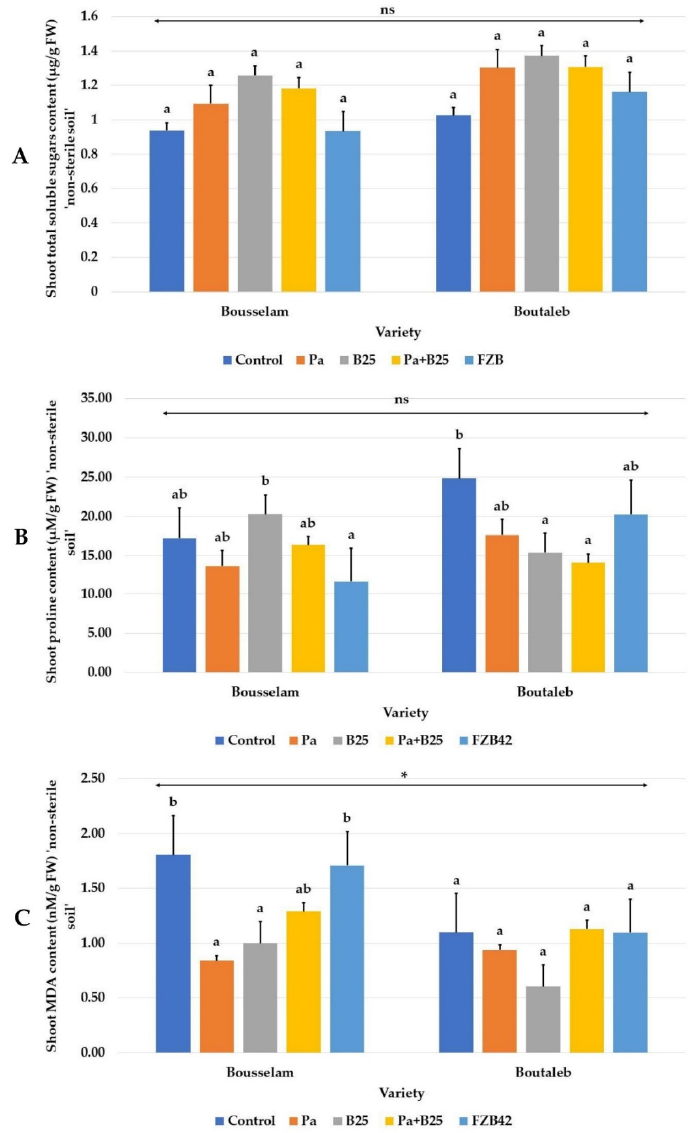
Figure 11. Effect of bacterial inoculation on ( A ) shoot total soluble sugars content (mg/g FW), ( B ) shoot proline content (µg/g FW), and ( C ) shoot malondialdehyde (MDA) content (µM/g FW) of wheat plants grown on non-sterile soil of Bousselam and Boutaleb varieties. The bar plots represent the mean ± standard error of three different experiments. IBM SPSS Statistics v.24 was used to perform statistical analysis, using a two-way ANOVA and Tukey’s multiple comparison post-test. Significant differences are displayed as: * p < 0.05. ns: non-significant.